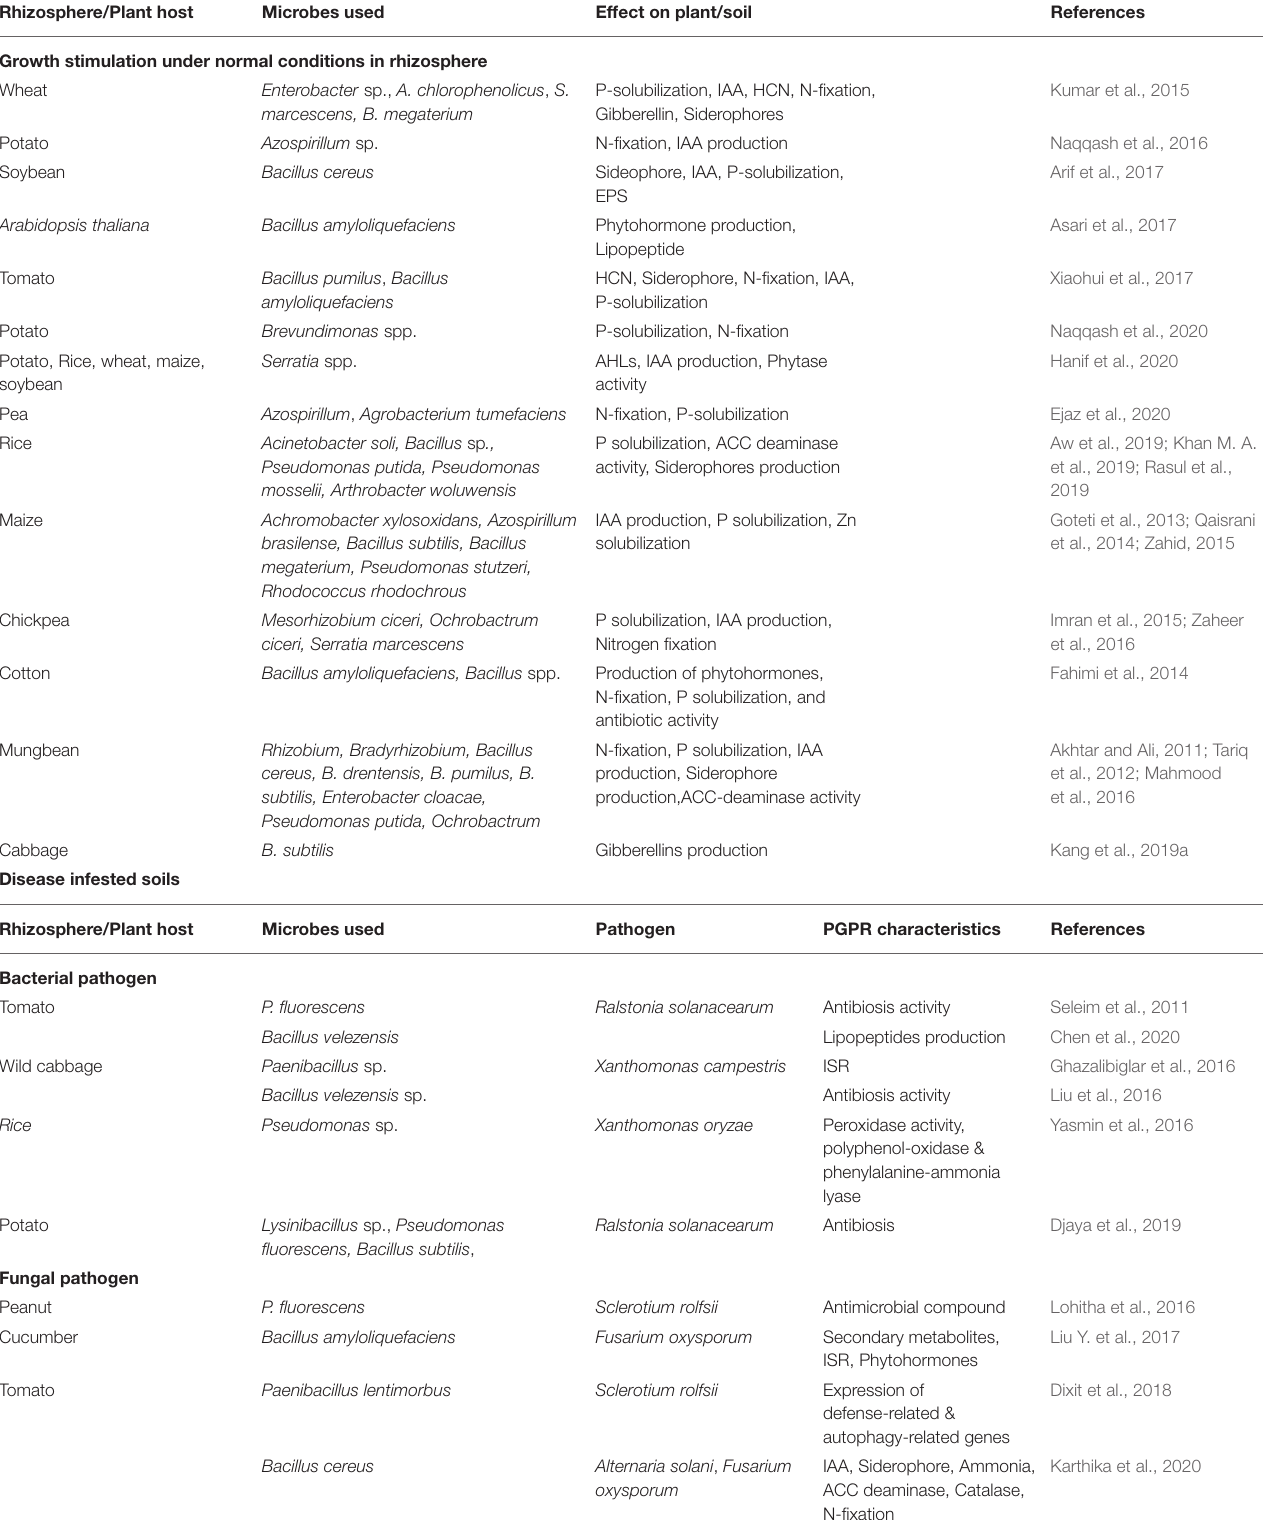
TABLE 1 | Role of rhizosphere engineering with PGPR on plant growth and stress